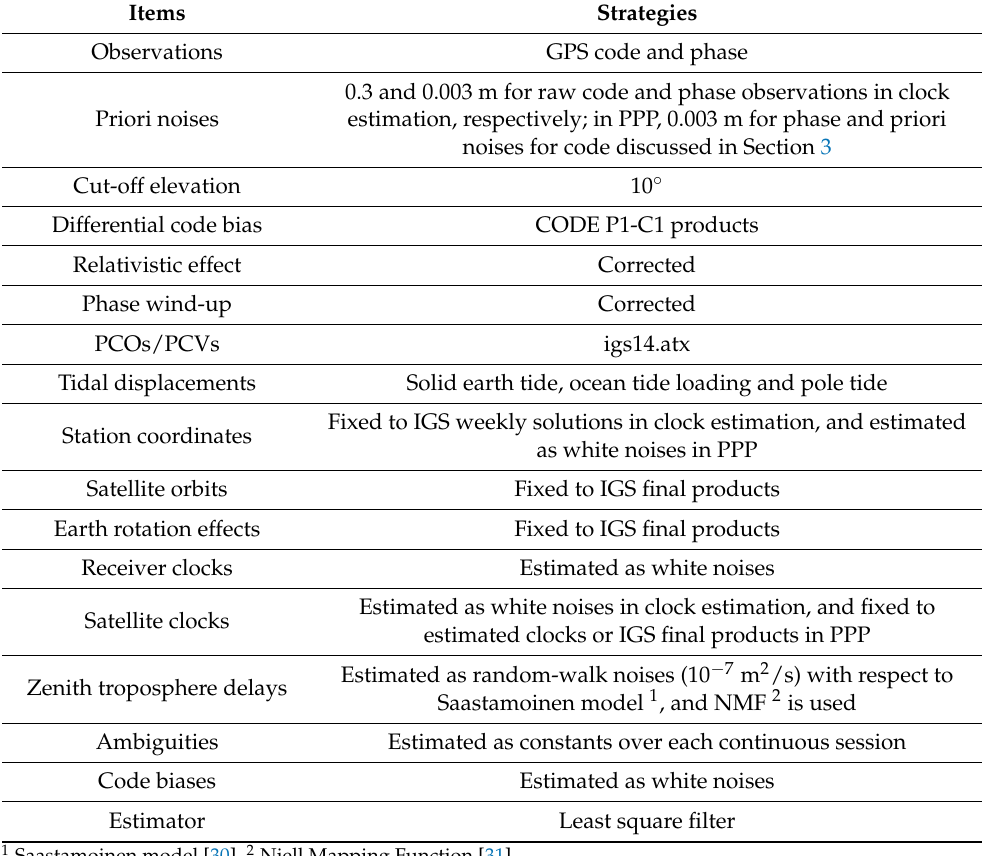
Table 1. Detailed strategies for satellite clock estimation and